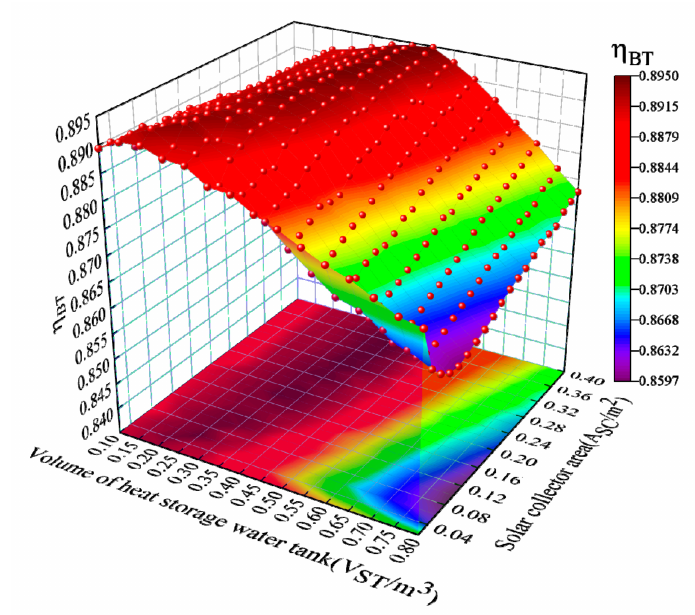
Figure 13. Diagram of η BT changes as A SC and V ST